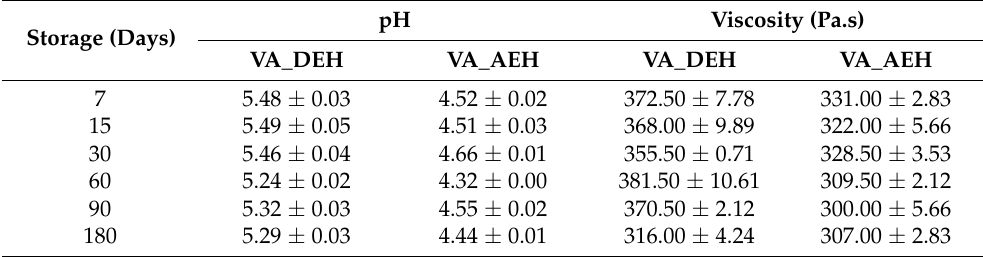
Table 4. Storage pH and viscosity parameters of Viscum album hydrogels. Temperature (40 ± 5 ◦ C), humidity (75 ±